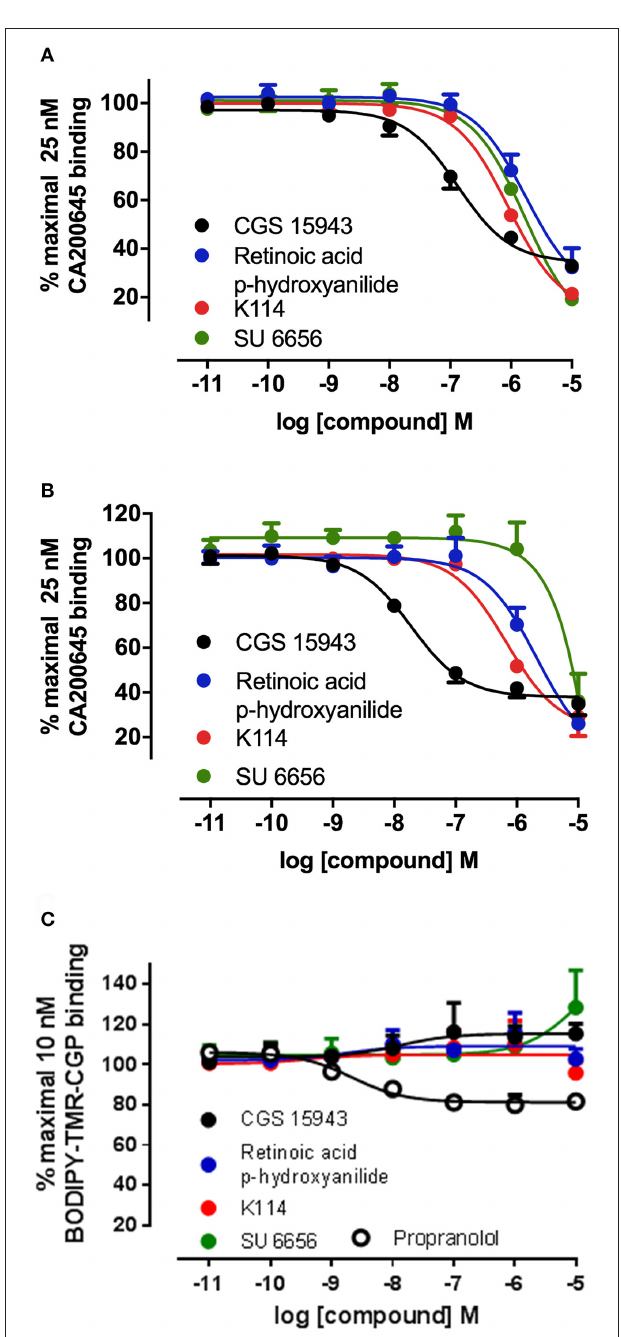
FIGURE 4 | Competition binding curves at the A 1 AR, A 3 AR, and β 2 AR for three hits identified from the LOPAC library. CHO cell lines stably expressing A 1 AR (A) , A 3 AR (B) , or β 2 AR (C) were incubated with 25nM CA200645 (A 3 AR and A 1 AR) or 10nM BODIPY-TMR-CGP ( β 2 AR) in the absence or in the presence of increasing concentrations of the indicated compounds. Values are mean ± SEM from three independent experiments performed in triplicate.